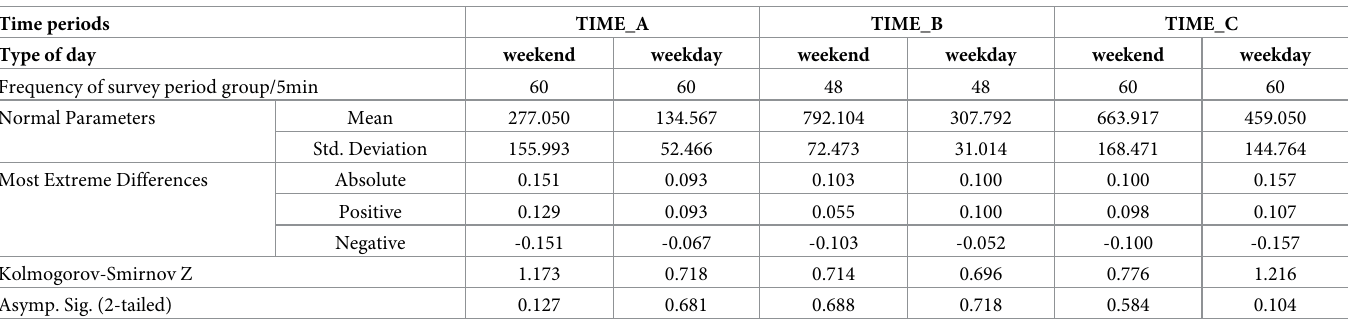
Table 2. One-Sample Kolmogorov-Smirnov Test